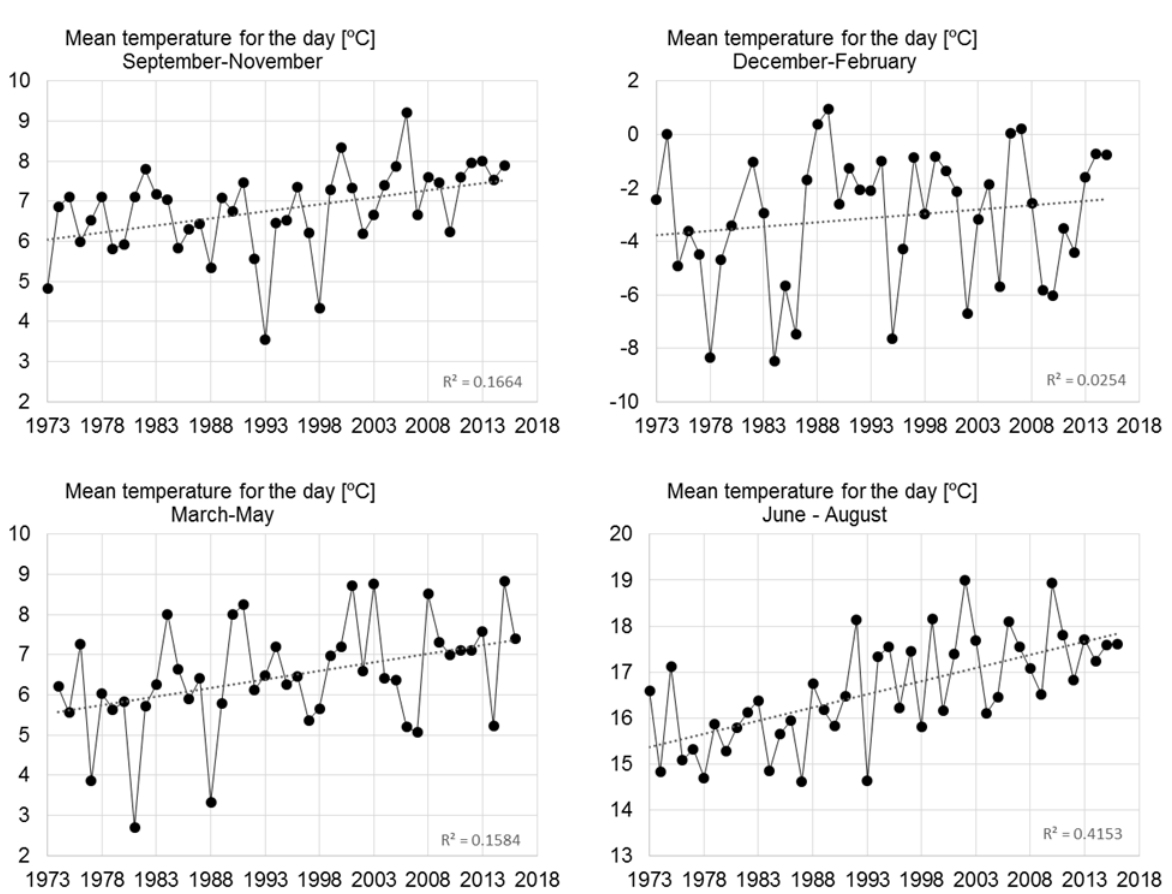
Figure 11. Mean daily temperature at Suwałki (calculated quarterly), 1973–2016. Based on online data provided by the National Climatic Data Center